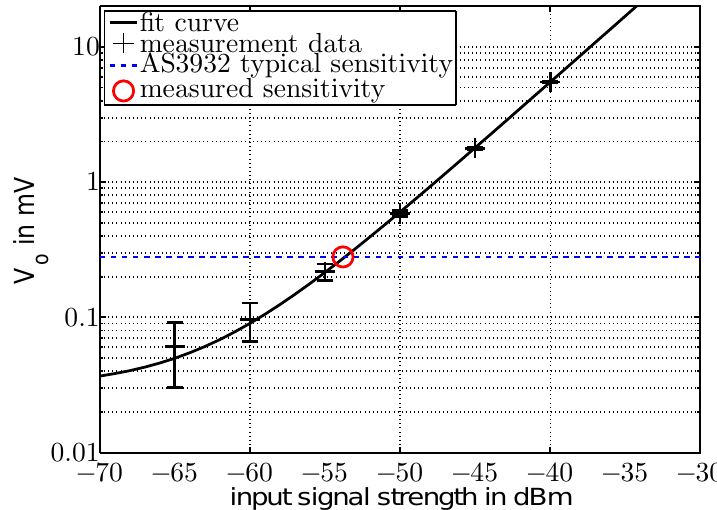
Figure 10. Measured voltage at the rectifier output with two active antennas. Typical sensitivity of the AS3932 is depicted as the blue dotted line. The red circle marks the measured